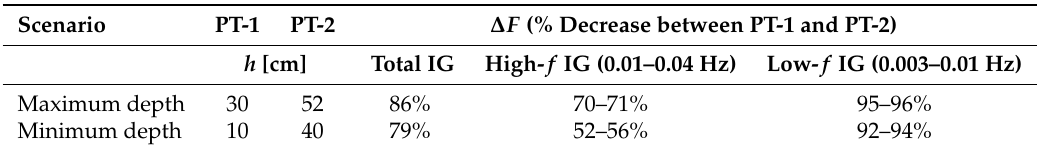
Table 1. Mean water depth h scenarios for estimation of the cross-barrier change in IG energy flux ∆ F during overwash ( − 4 to − 3 h) given uncertainties in bed